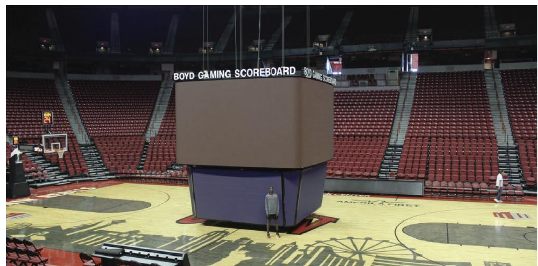
Figure 1: New center-hung scoreboard for the Tomas and Mack